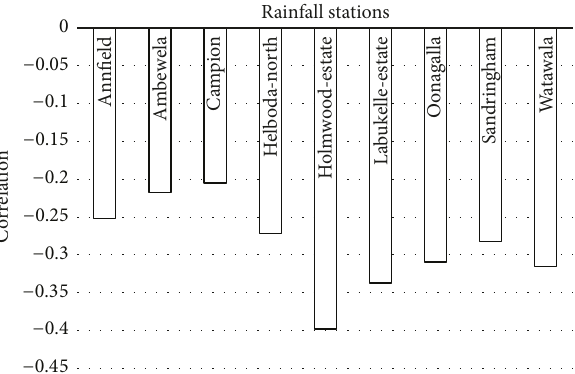
Figure 4: Correlation between mean SST (Nino–3 region) and JJAS mean rainfall for 9